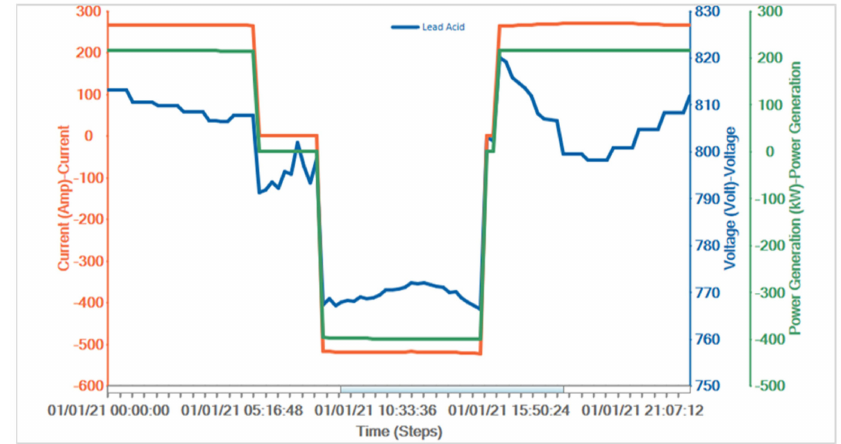
Figure 17. Lead–acid combined plots.